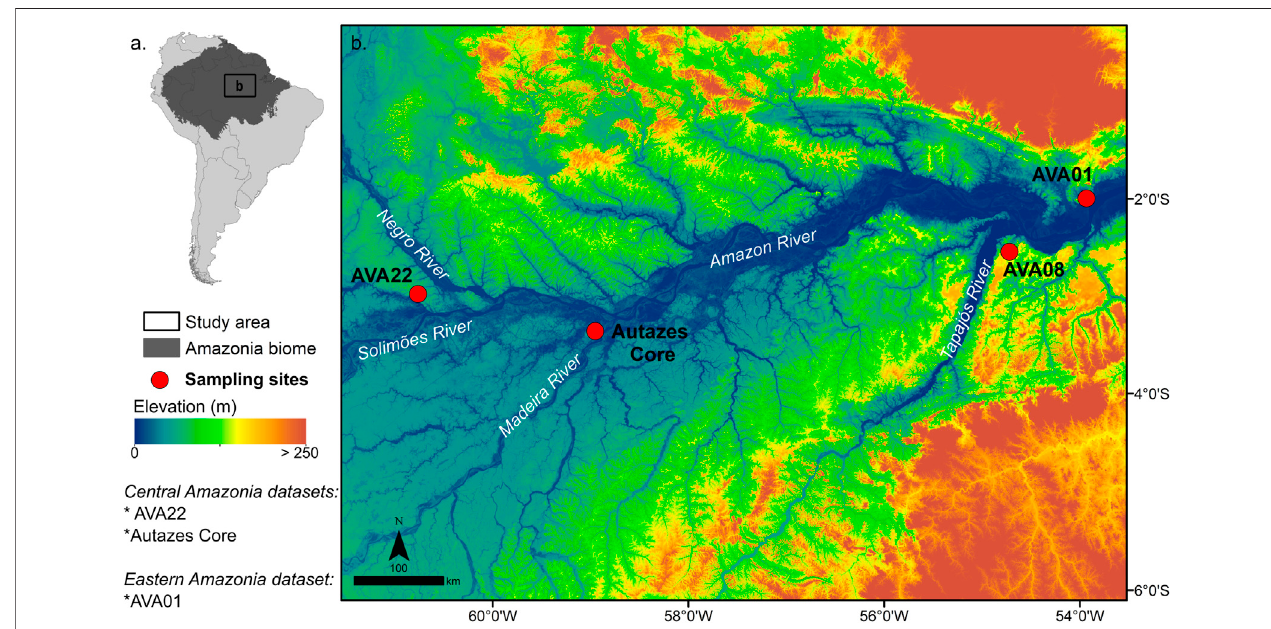
FIGURE 1 | (A) Location of the Amazonia biome within South America and study area within this biome; (B) digital elevation model (DEM; from Shuttle Radar Topography Mission — SRTM) and sampling locations in Central (AVA22 and Autazes core) and Eastern (AVA01 and AVA08) lowland Amazonia.